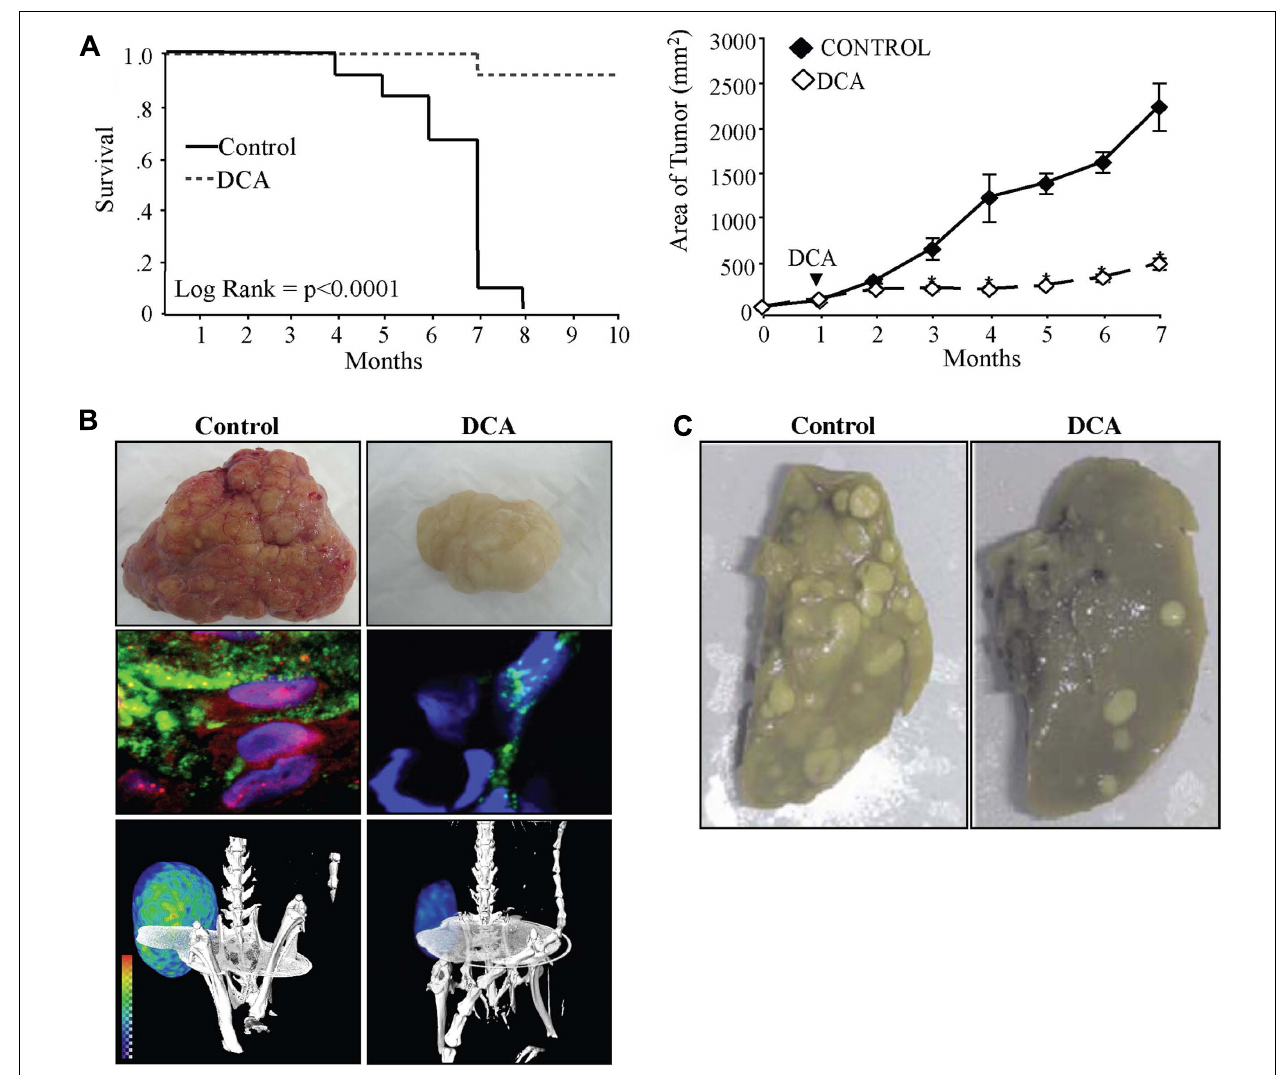
FIGURE 2 | (A) DCA increases the survival (left) and decreases the tumor growth (right) of xenotransplant animals with nSCLC tumors. (B) DCA-treated animals have tumors with decreased vascularity (top) and decreased nuclear localization of hypoxia-inducible factor 1 α (HIF1 α ; red, nuclear stain DAPI: blue) and angiogenesis (lectin: green, middle panel). DCA-treated animals